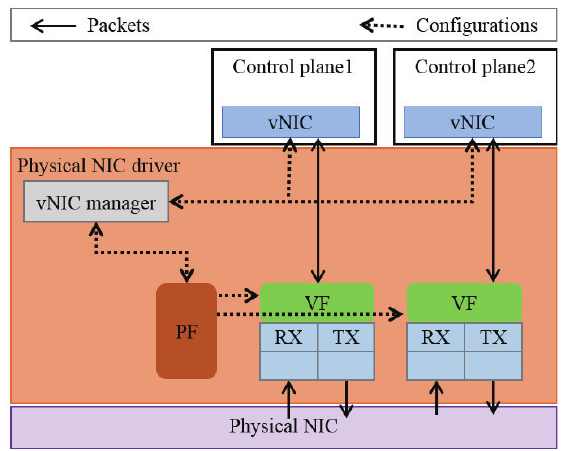
Figure 1. The separate execution environment (SE2) is enabled by the virtual network interface card (vNIC) manager that assigns a virtual function (VF) to each control plane. PF, physical